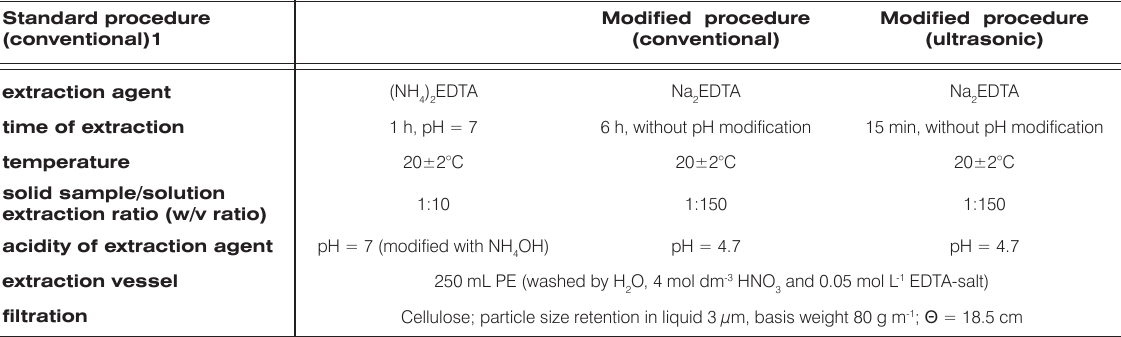
Table 2. Standard and modified procedures of conventional and ultrasonic single-step extraction into 0.05 mol L -1 EDTA solution. Standard procedure